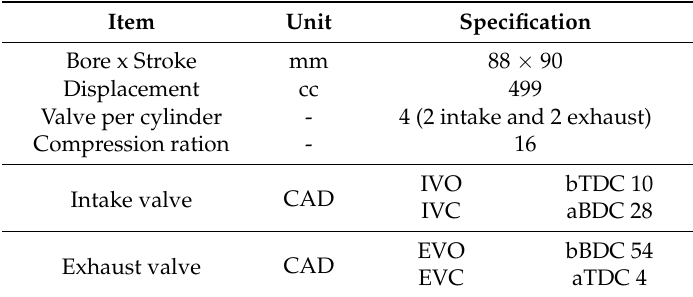
Table 2. Specification of R-engine used in this